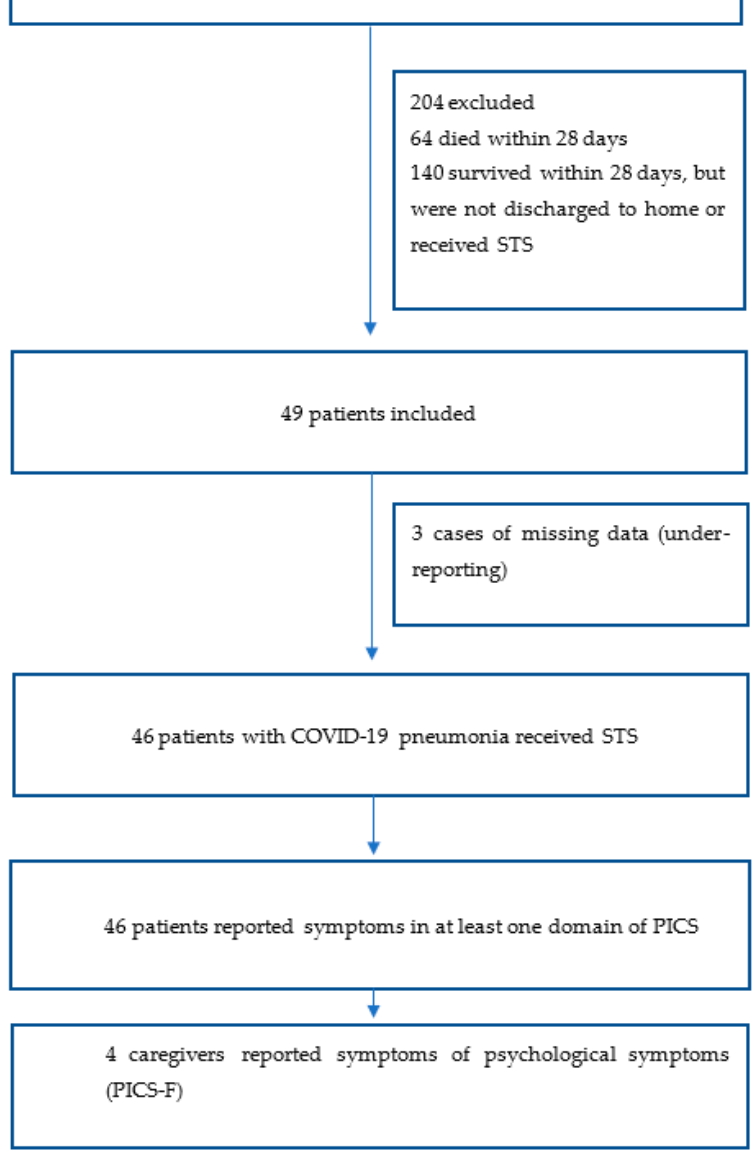
Figure 1. Patient flow diagram.